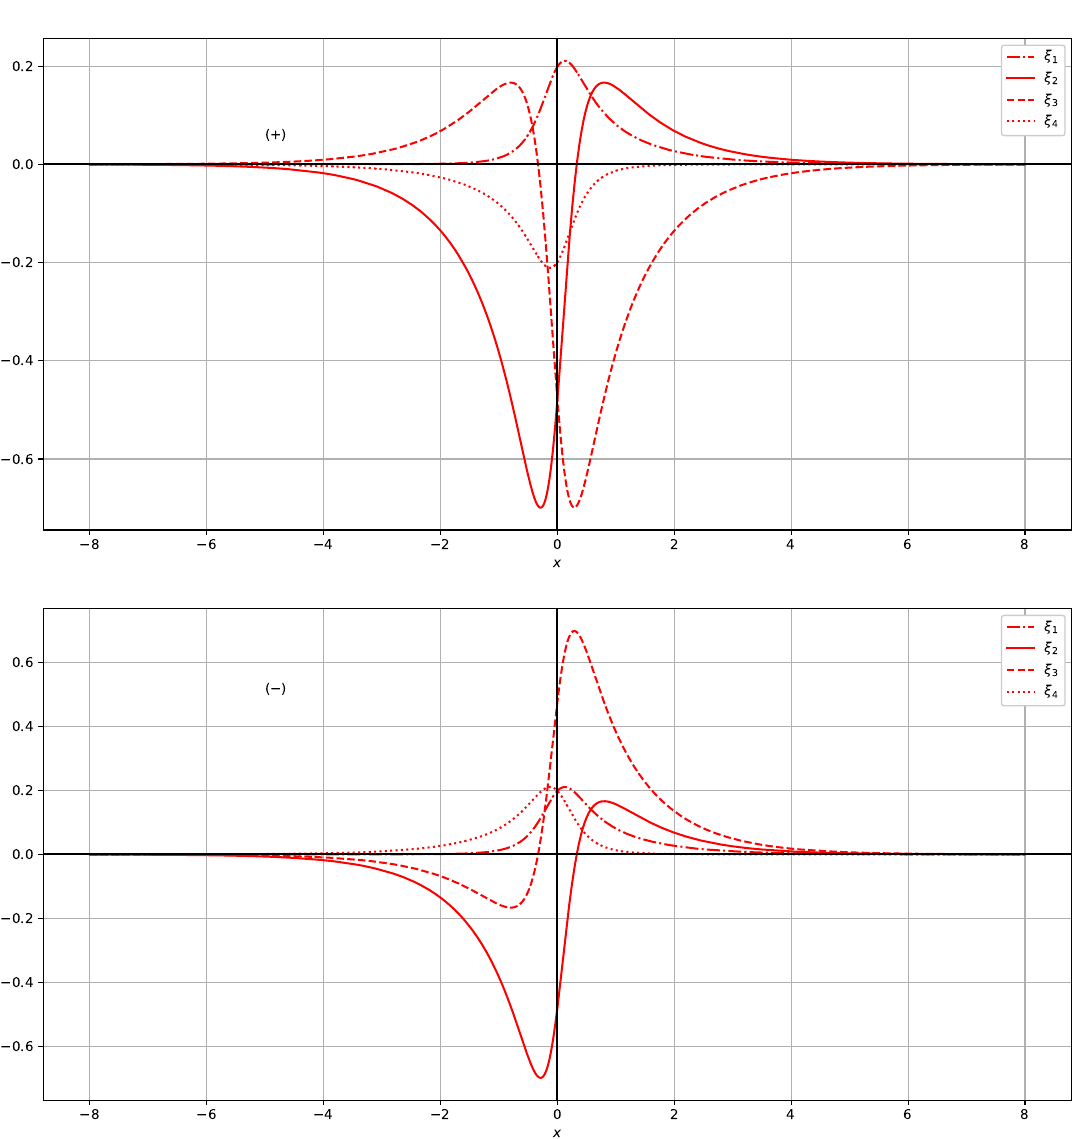
Figure 19 . Numerically simulated bound state components as functions of x for positive parity σ = +1 (Top figure) and negative parity σ = − 1 (Bottom figure). They are hosted by the kink with θ 0 = 2 π (red kink in the figure 3